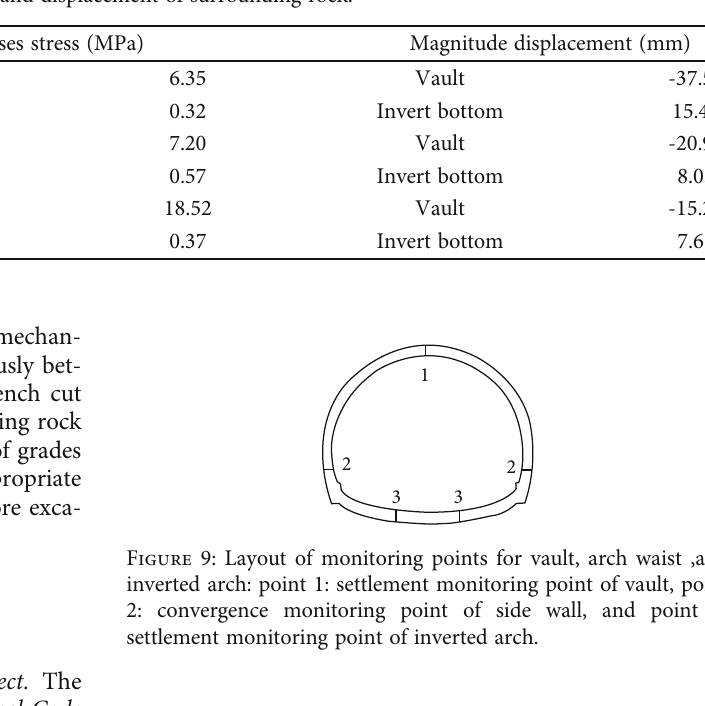
Table 4: Stress and displacement of surrounding rock.